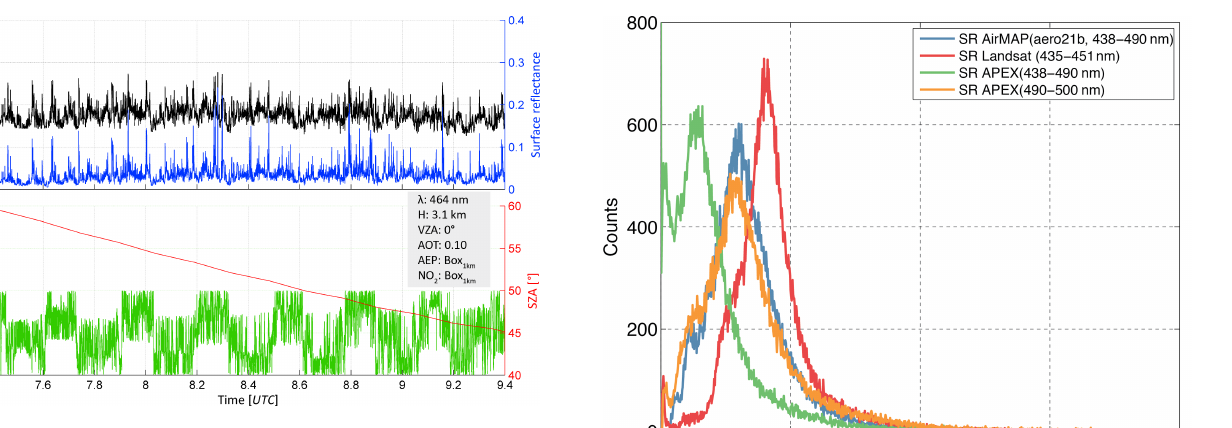
Figure 6. Time series of NO 2 AMFs for the morning flight on 21 April 2016, computed with DISORT based on the RTM parameters from the AirMAP instrument. The data are plotted for only the nadir observations in each across-track scan line.